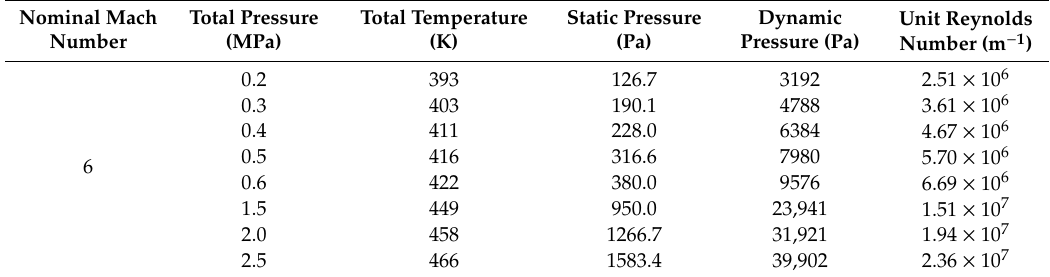
Table 6. The detailed flow field parameters of wind tunnel for dynamic calibration exploring.